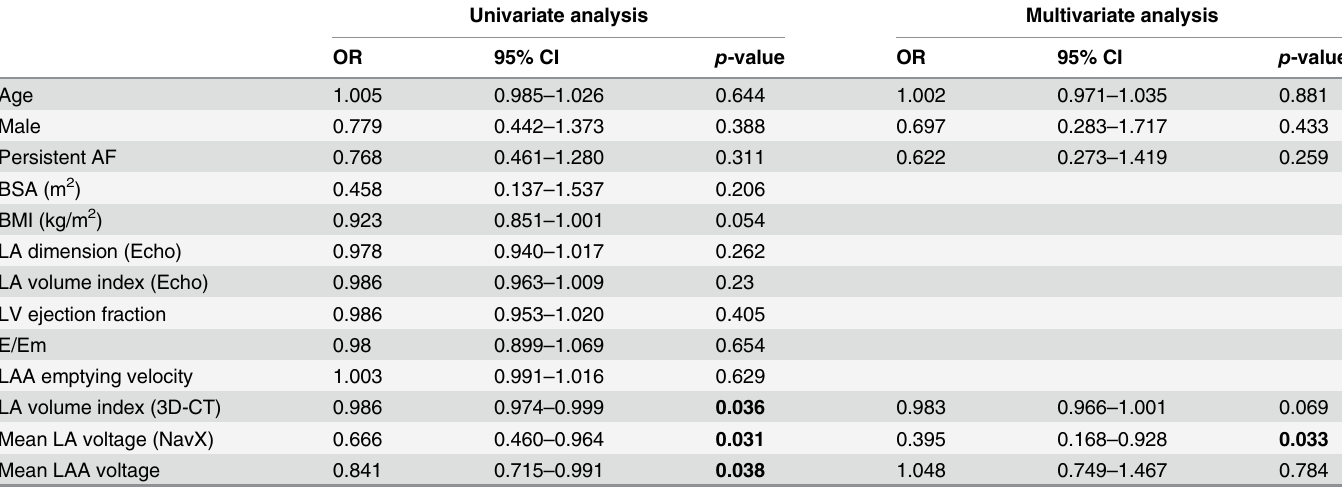
Table 3. Multivariate regression analysis of factors related to low LA compliance (LApp (cid:1) 13mmHg).